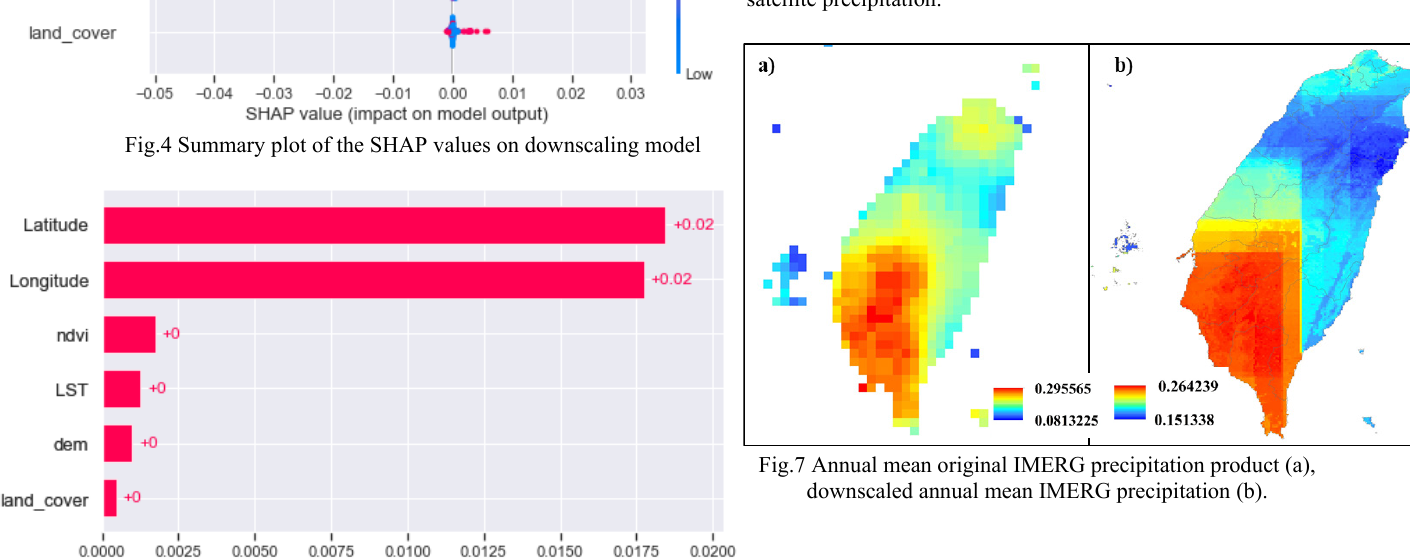
Fig.4 Summary plot of the SHAP values on downscaling model